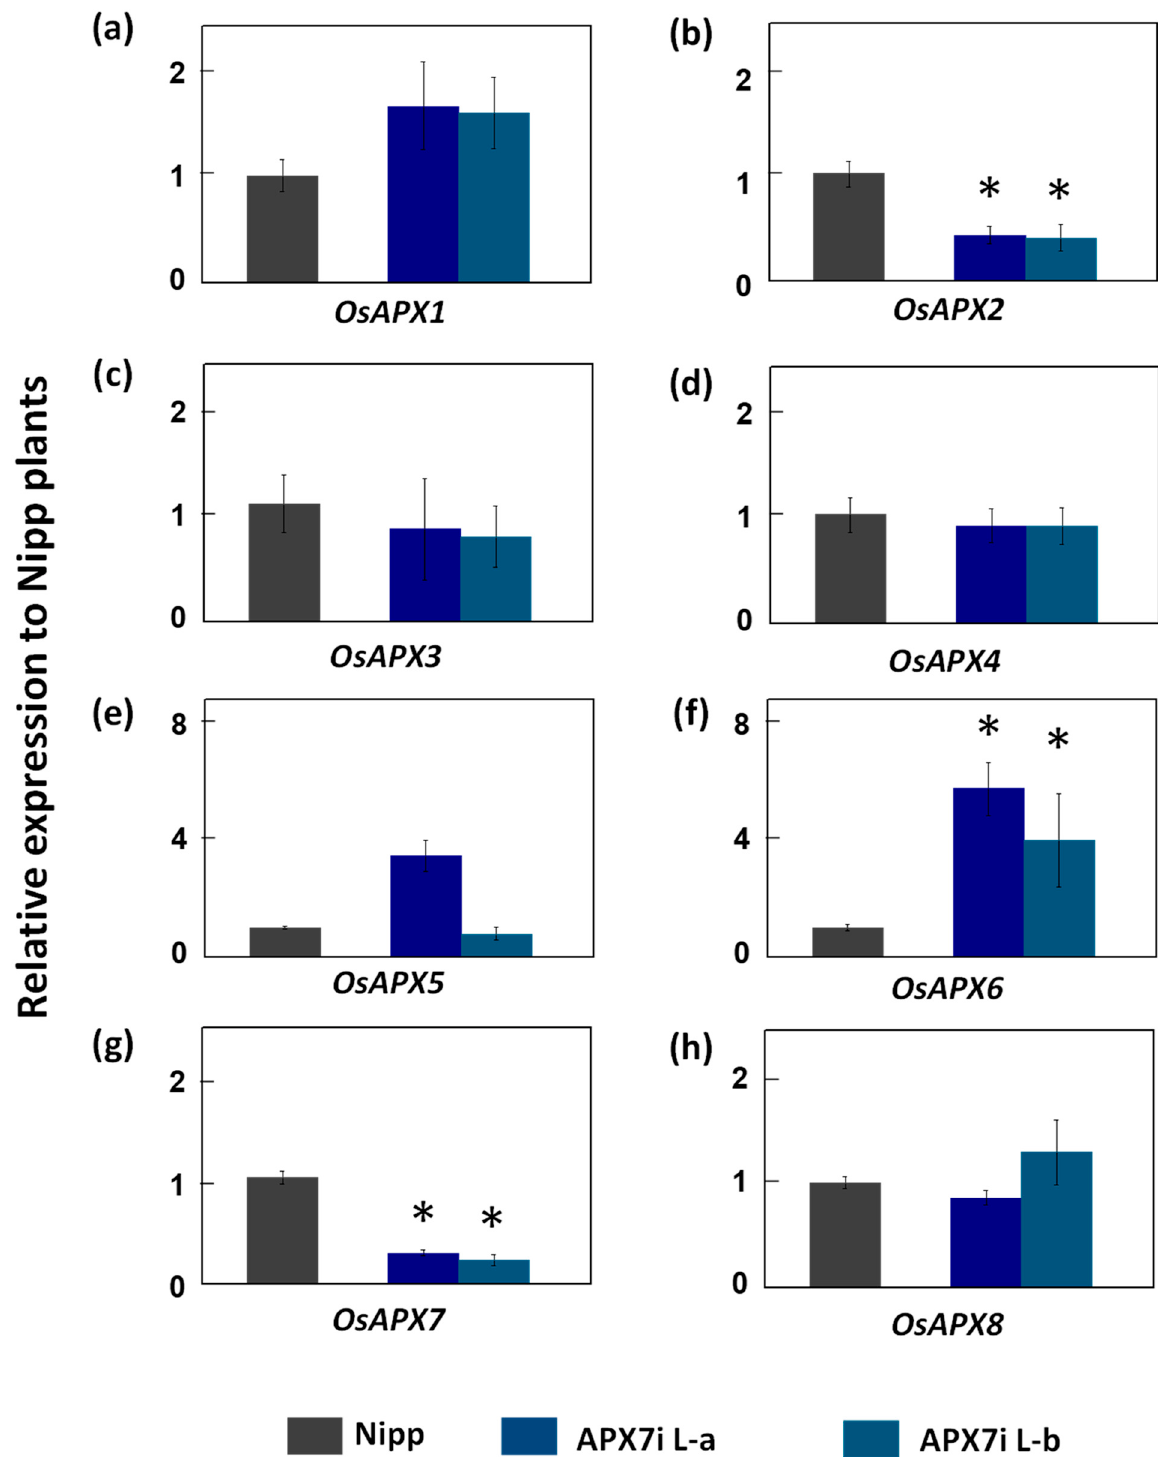
Figure 2. Gene expression analysis of ascorbate peroxidase family and other chloroplastic peroxidases in leaves of Nipp (Nipponbare) and APX7i plants. Genes analysed were ( a ) OsAPX1 , ( b ) OsAPX2 , ( c ) OsAPX3 , ( d ) OsAPX4 , ( e ) OsAPX5 , ( f ) OsAPX6, ( g ) OsAPX7 , (h) OsAPX8 , ( i ) OsAPX-R , and ( h ) OsGPX4 . The values were normalized by at least three constitutive genes and represent the average ± SE of relative expression to Nipp plants in at least three independent experiments. * indicates populations significantly different with p < 0.05.